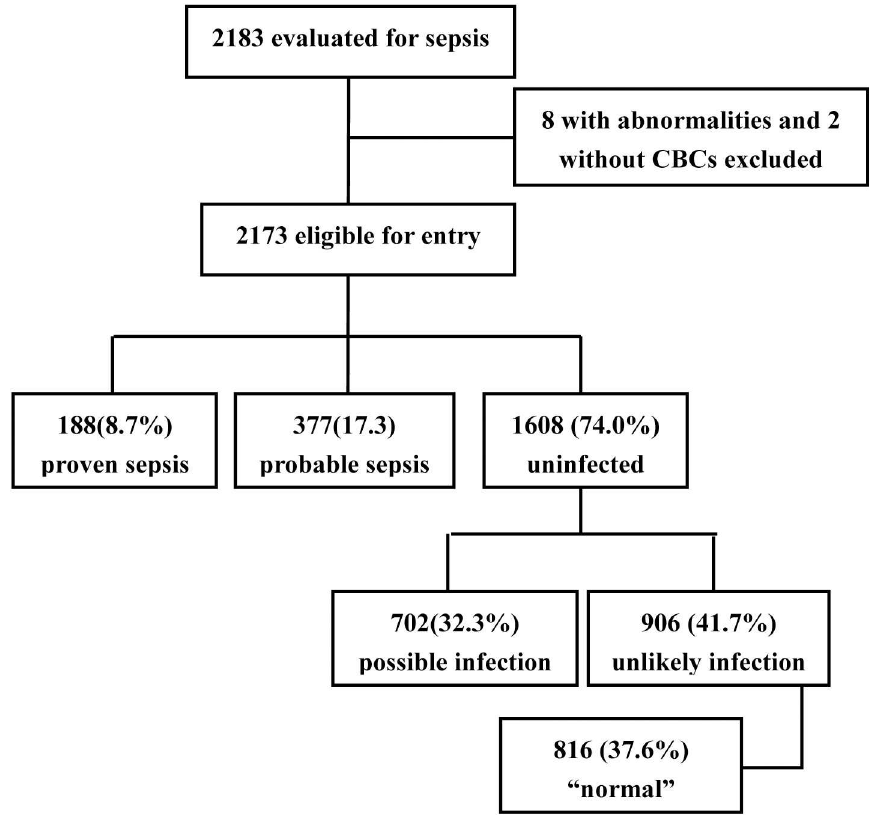
Fig 1. Distribution of neonates with or without sepsis or infection (April 2008to March